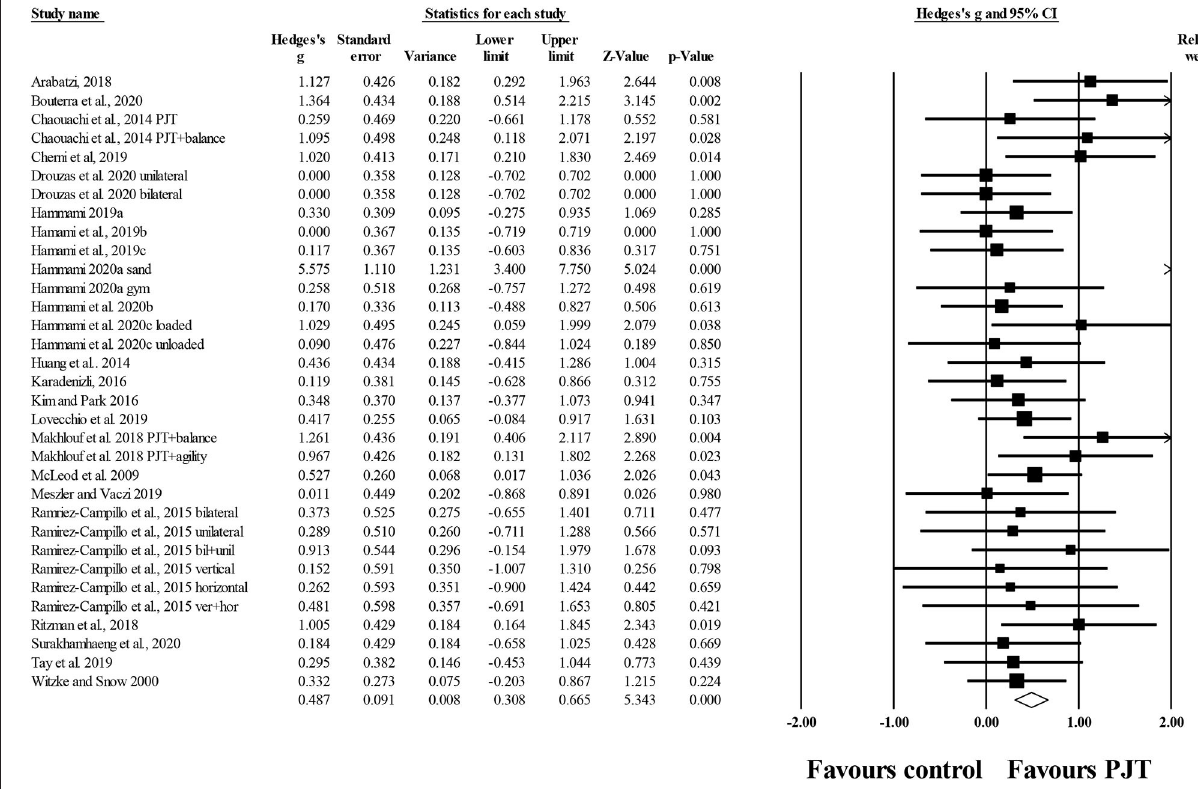
FIGURE 6 | Forest plot of changes in overall static balance (i.e., all static tests included) in participants that completed a plyometric jump training (PJT) program compared to participants allocated as controls. Values shown are effect sizes (Hedges’s g) with 95% confidence intervals (CI). The size of the plotted squares reflects the statistical weight of each study. The diamond reflects the overall